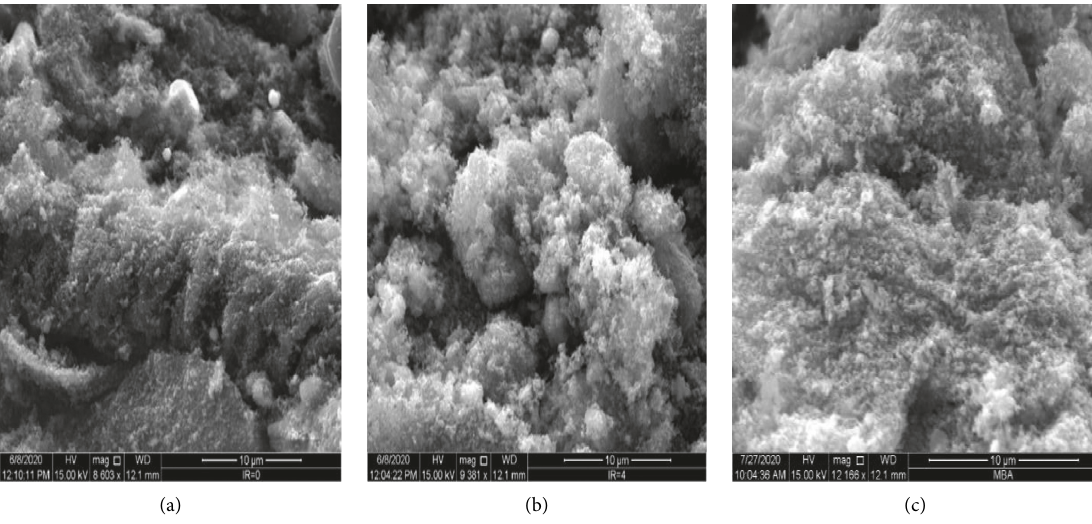
Figure 3: SEM image scrap tire for raw (a), after activation (b), and after adsorption (c).